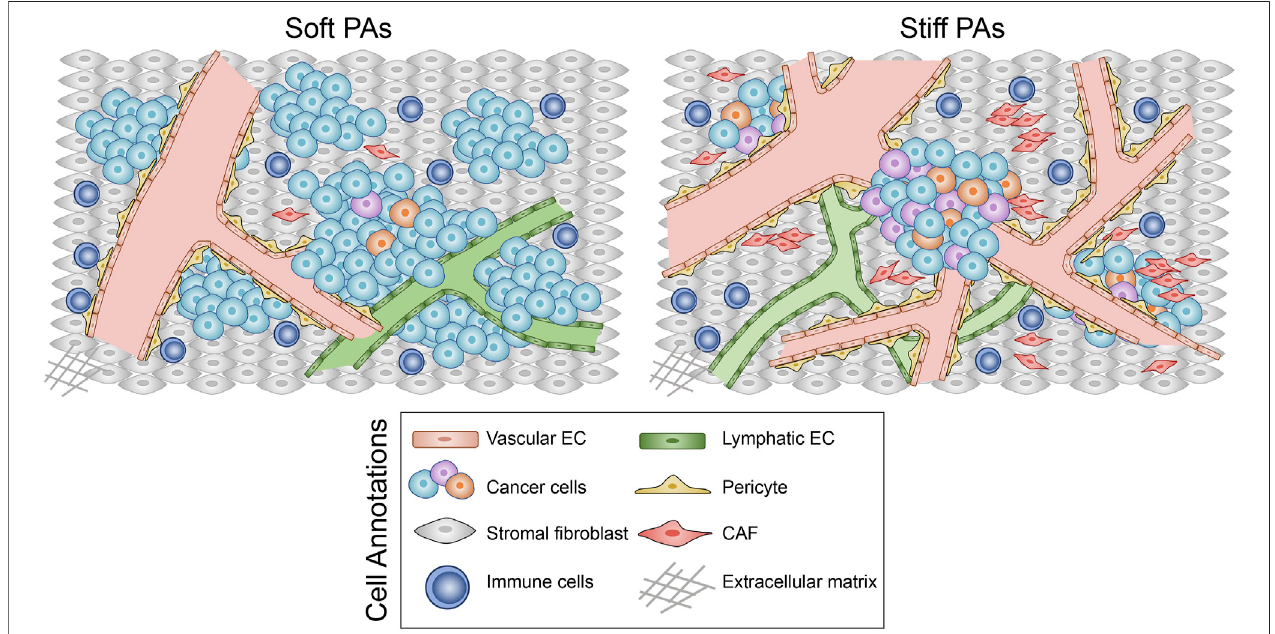
FIGURE 6 | Schematic diagram illustrating the general TME patterns of soft and stiff tumors.